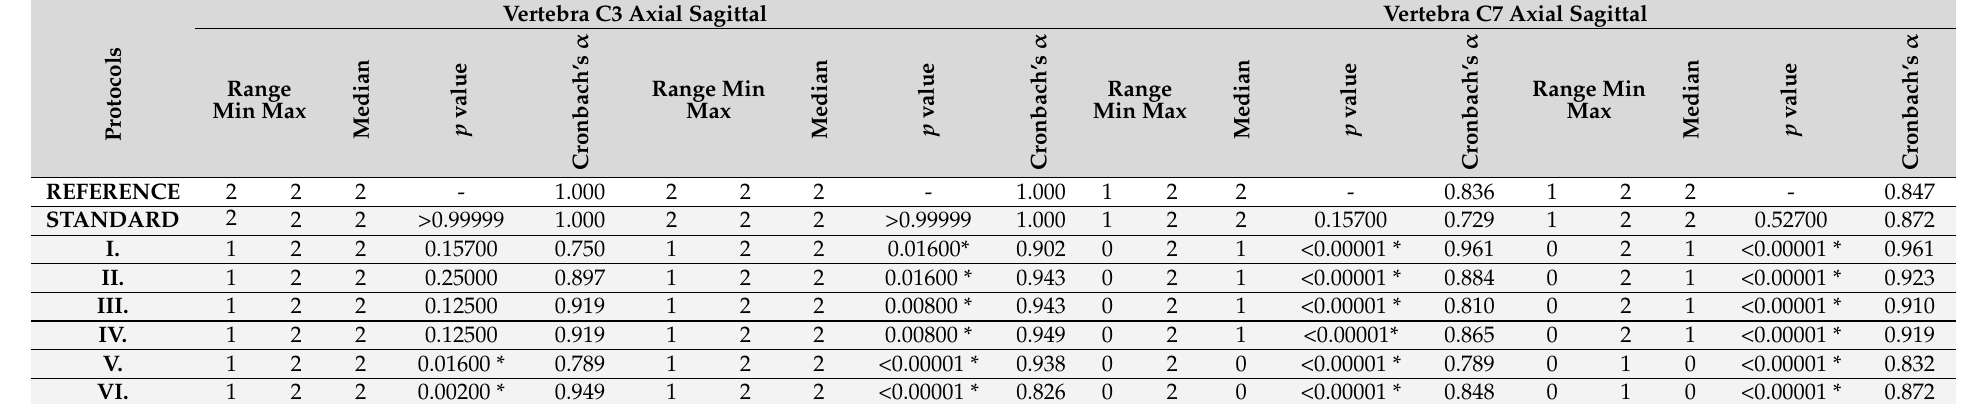
Table 2. Image quality (IQ) ratings, medians, and ranges of subjective image ratings of all scan protocols of the patient study as well as the ICC and p values of the comparisons are detailed in the table. Significant p values are indicated with